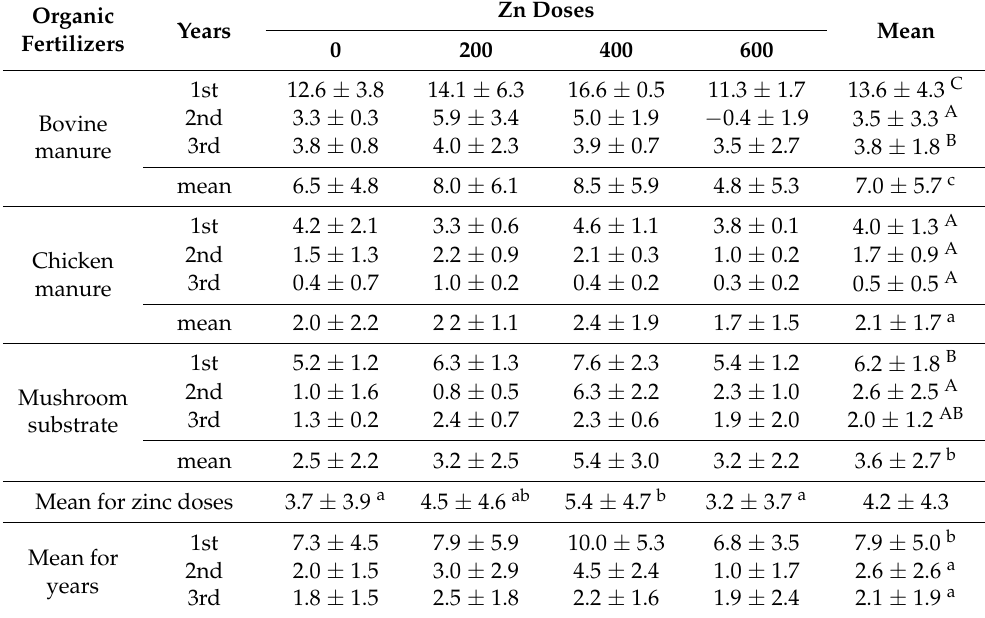
Table 6. Phosphorus use efficiency (%) from organic fertilizers under different zinc doses (Zn mg · kg − 1 of soil) and organic fertilization (mean ±